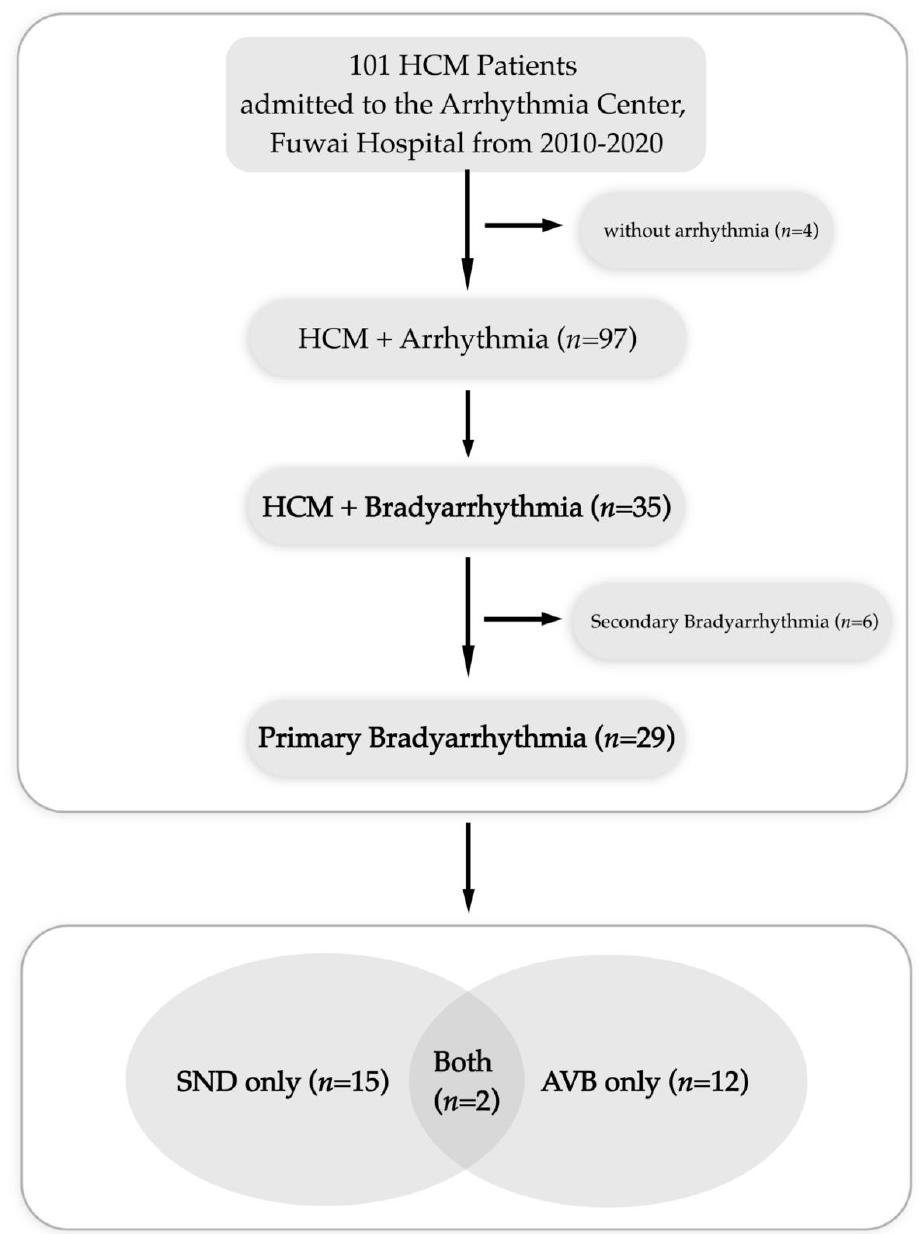
Figure 1. Flow chart of all patients with arrhythmias. HCM, hypertrophic cardiomyopathy; SND, sinus node dysfunction; AVB, atrioventricular block.